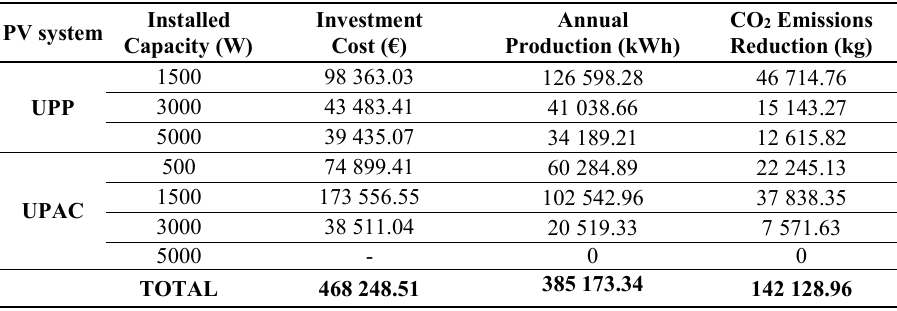
Table 4. E3 Impacts - Moderate Scenario.